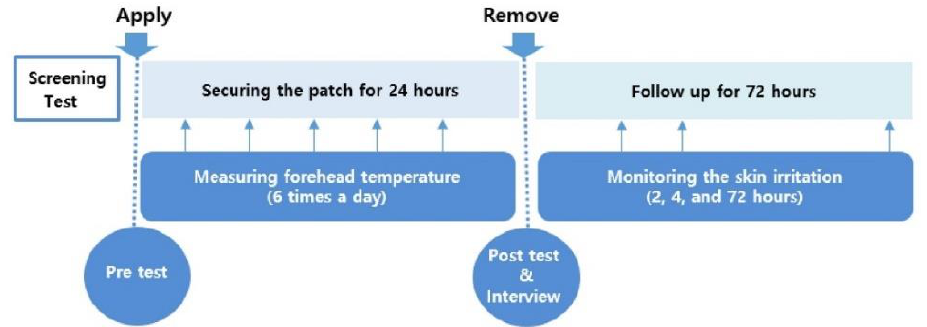
Figure 1. Study Figure 1. Study procedures.